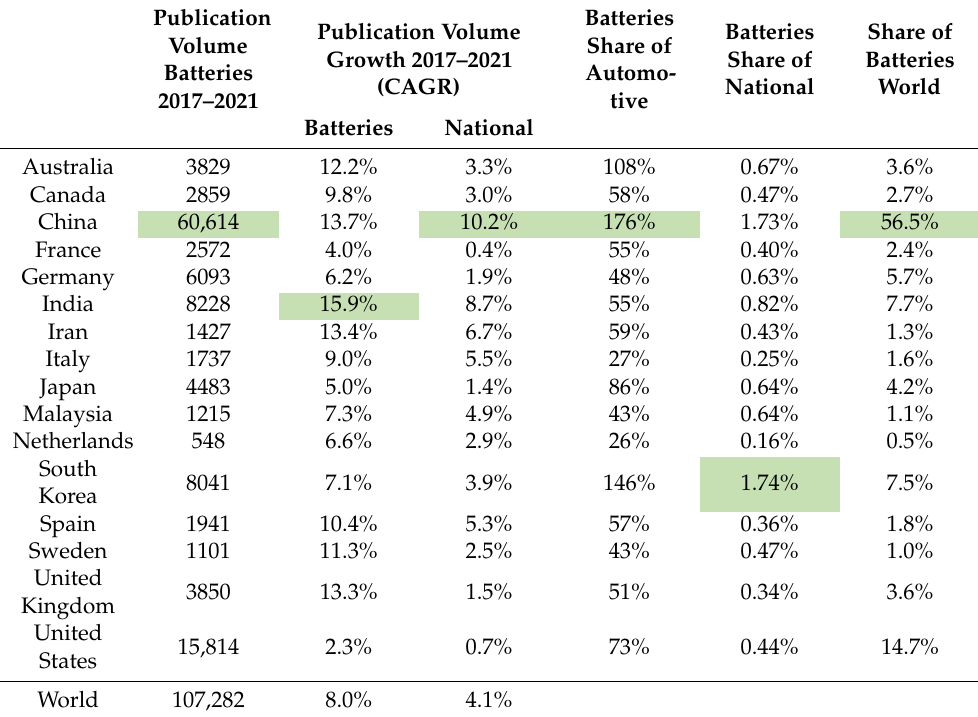
Table 3. Key indicators for battery